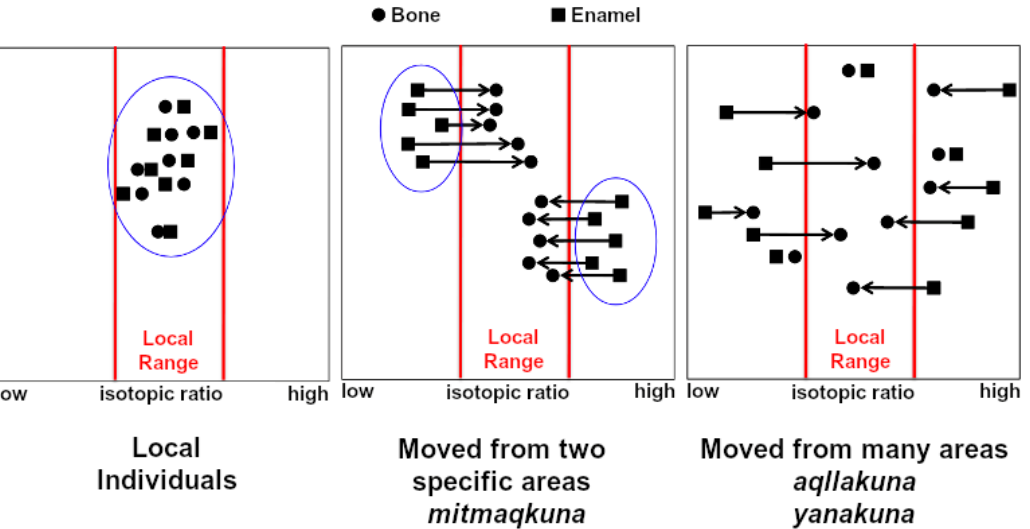
Figure 2. Schematic comparison of isotopic patterns of residential mobility for local individuals, mitmaqkuna or aqllakuna / yanakuna . Vertical axis separates samples in space. Modified with permission from [13].